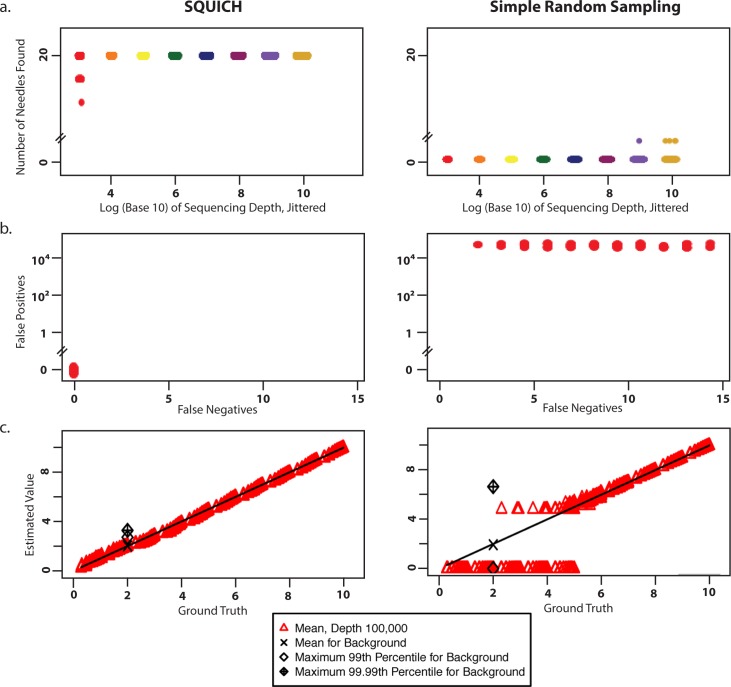
Performance of Simulations.2a. Simulation 1: In a background of one species at abundance 1015, we compare detection of the “needle” species by SQUICH and SRS for varying sampling depths; each sampling depth is depicted in a unique color, with one point for each replicate. (1000 replicates, x-axis is log10-scale and jittered). SQUICH (L); SRS (R). Note that due to the number of replicates, there is a large overlap of the points, despite the jittering. 2b: Simulation 2: SQUICH enables detection of small fold changes, here 2-fold in 20 species, in a background of >260,000 species. Here SQUICH (L) and SRS (R) both use 105 samples. (100 replicates; x- and y-values jittered, y-axis is log10-scale). 2c: Simulation 3: Detection performance of SQUICH (L) and SRS (R) (100 replicates each) in quantifying species across 10 orders of magnitude, at a sampling depth of 100,000. SQUICH (L) enables detection of small and large abundances across this dynamic range. (The x-axis and y-axis are log10-scale and jittered; the axes are labeled by the logs of the values).